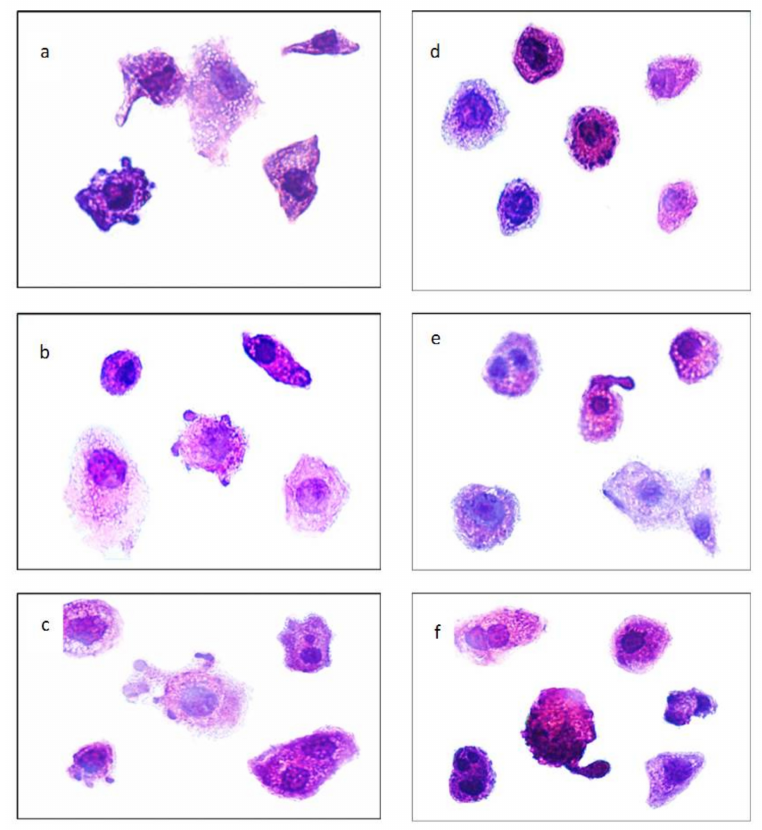
Figure 6. Micrograph showing criteria of apoptosis in Hep-2 cells treated with increasing concen- trations of propolis (half IC 50 of propolis ( a ), IC 50 of propolis ( b ), double IC 50 of propolis ( c )) or propolis encapsulated-liposome (half IC 50 of propolis-encapsulated liposome ( d ), IC 50 of propolis- encapsulated liposome ( e ), and double IC 50 of propolis encapsulated-liposome ( f )) for 24 h at the power of 1000X